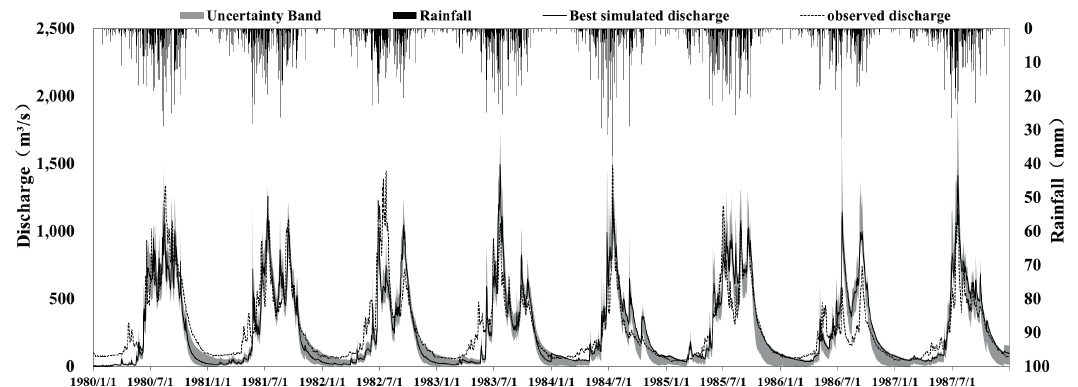
Fig. 4 The observations and simulation results of the daily river discharge for the calibration and validation period at Ganzi gauging station.